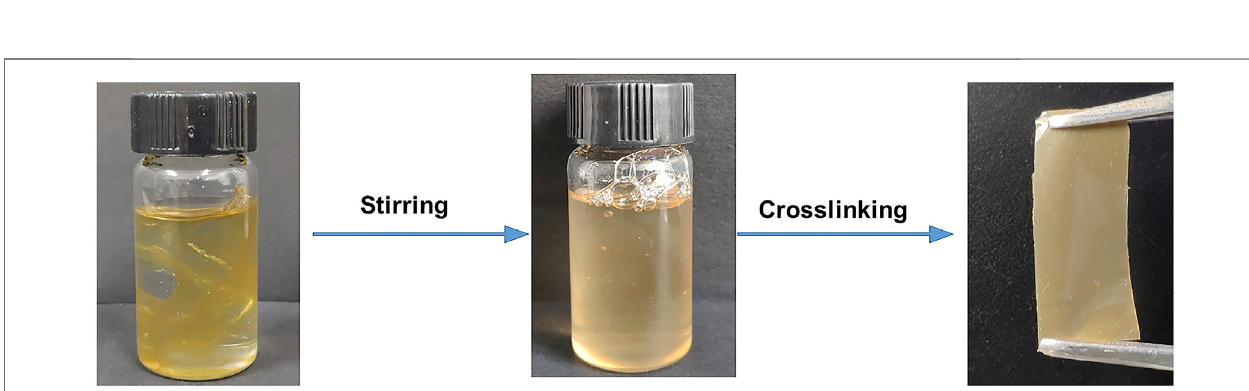
FIGURE6| Thetensilecurvesofhydrogenbondcross-linkedsiliconeelastomers,H-17toH-20 (A) andcovalentbondcrosslinkedsiliconeelastomers, C-18toC- 21 (B) , after adding the reinforcing fi ller.